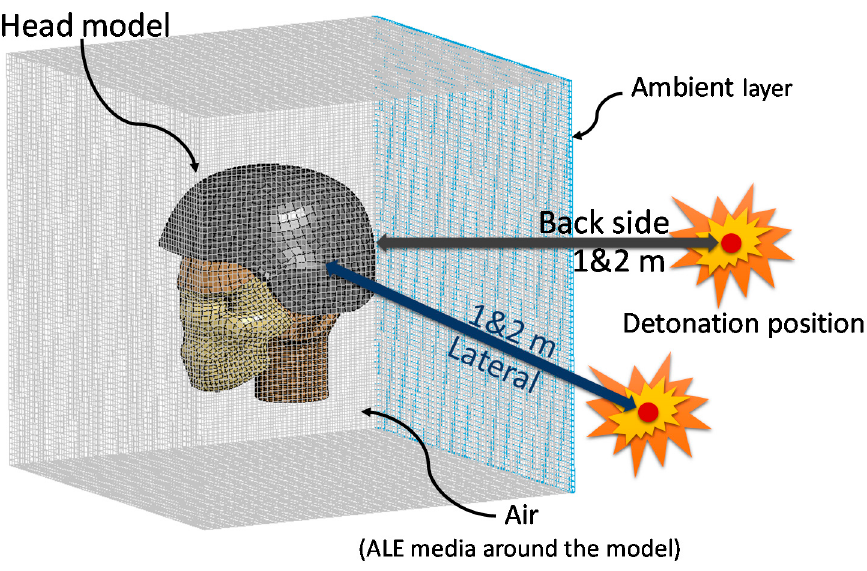
Figure 3. The position of the detonation at side and back of the protected head model. Table 5. The summary of blast scenarios implemented in FE simulations to predict the ranges of strain rate associated to traumatic brain injuries